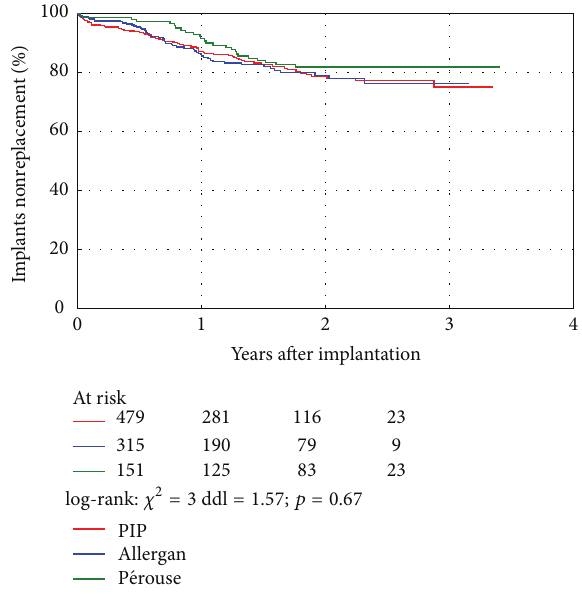
Figure 1: Breast implant